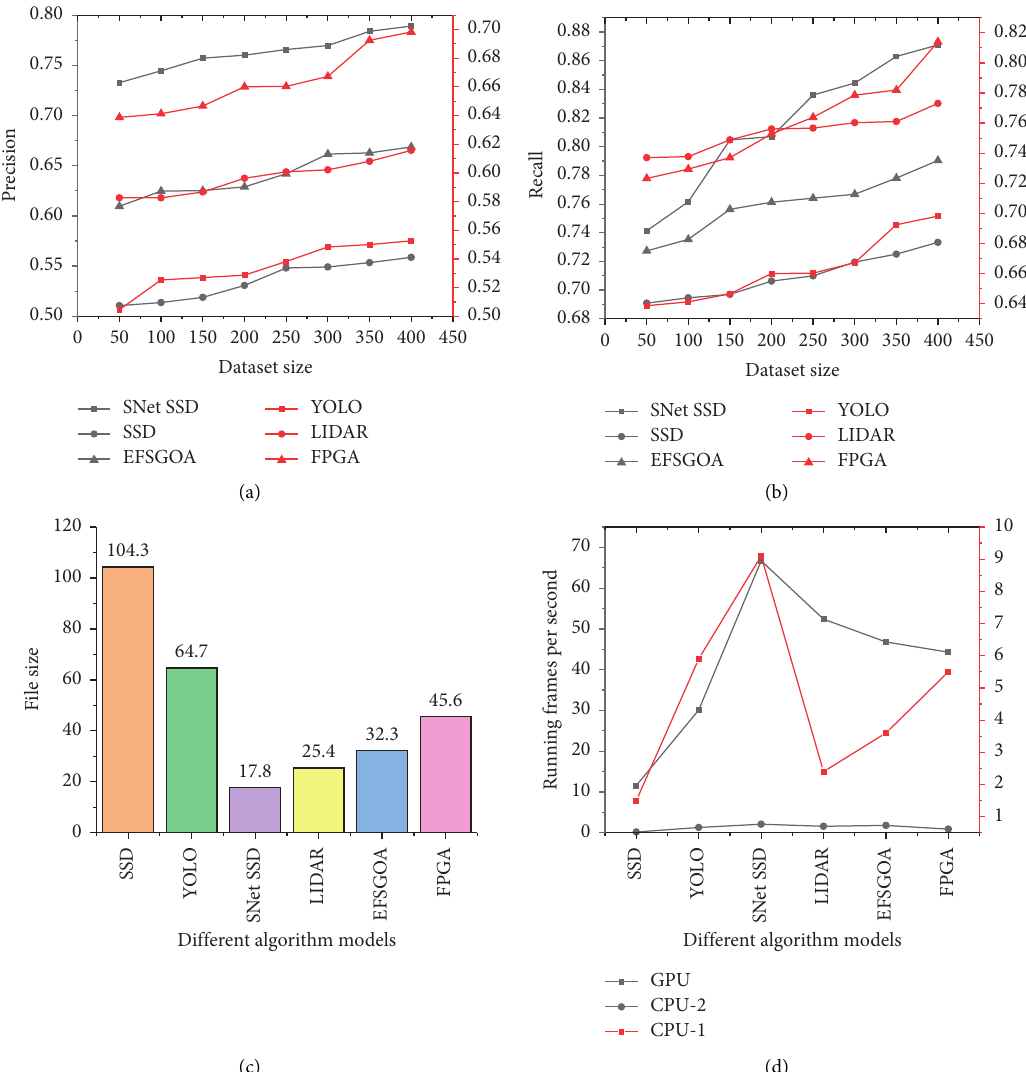
Figure 7: Comparison and analysis of the performance of different models.